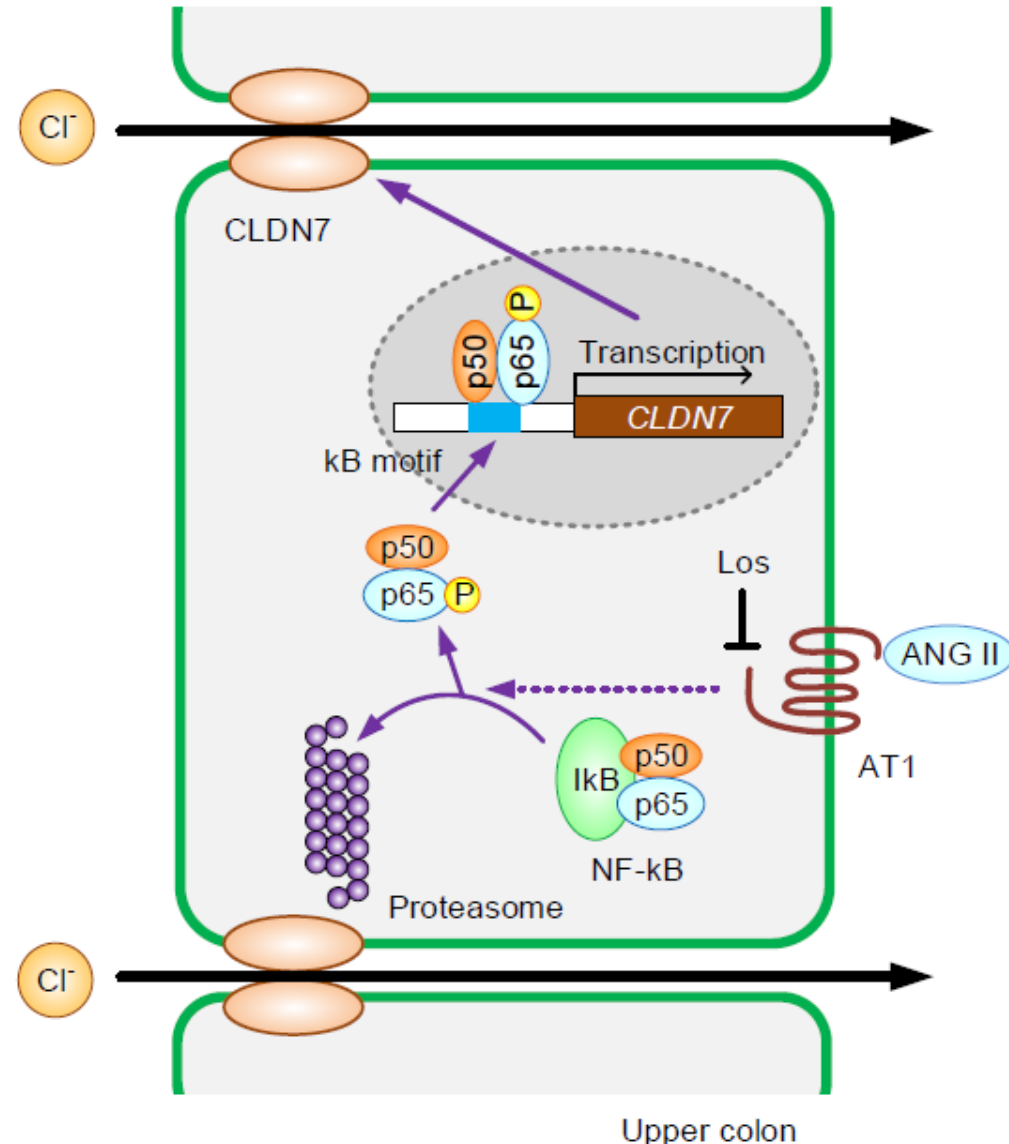
Figure 8. A putative model of ANGII-induced elevation of CLDN7 expression in the colon. ANGII increases the phosphorylation and nuclear localization of p65 subunit of NF- κ B mediated through the activation of AT1. The p65 subunit binds to the promoter region of CLDN7 and increases the expression of CLDN7, resulting in the elevation of Cl − absorption in the colon.